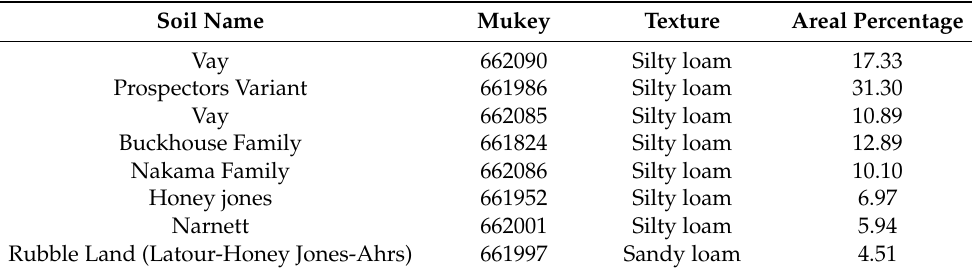
Figure 2. ( a ) Soil types and ( b ) land use types within the Upper North Fork basin. Table 1. Soil name, texture, and areal percentages within the watershed.